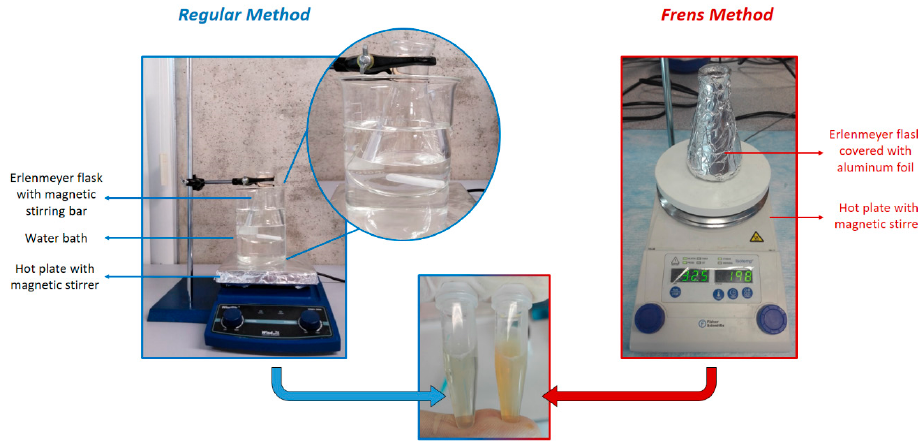
Figure 1. Setup for nanoparticle synthesis using the methods described in this protocol. The picture in the center compares the appearance of nanoparticle suspensions with these methods. Notice that the characteristic color of colloidal silver is more intense for the suspension obtained with the Frens method.